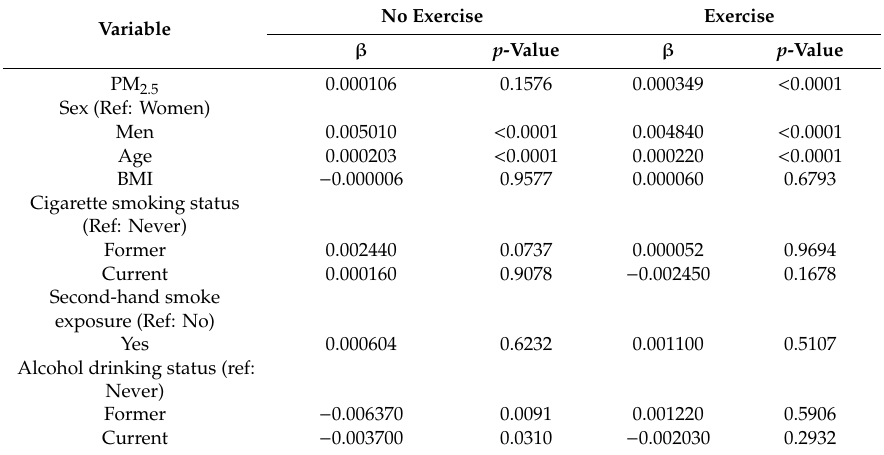
Table 3. Association between PM 2.5 and SOX2-promoter methylation in participants stratified by exercise habits.